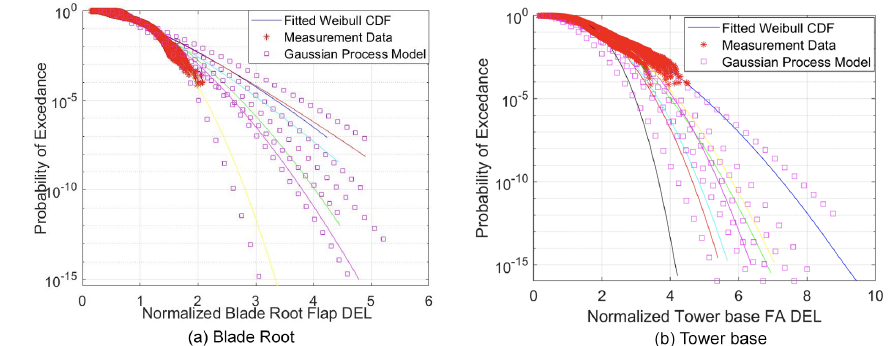
Figure 11. Comparison of the 10min (a) extrapolated blade root flap damage equivalent moment and (b) tower base fore–aft damage equiv- alent moment, using the Gaussian process method and measurement data on the C-08 turbine between 7 and 13ms − 1 . Blade: measurement 1-year DEL – between 1.9 and 2.3, Weibull CDF 1-year DEL – between 2 and 2.7, and GPA 1-year DEL – between 1.9 and 3.1. Tower: measurement 1-year DEL – between 3.3 and 4.4, Weibull CDF 1-year DEL – between 2.9 and 4.4, and GPA 1-year DEL – between 2.8 and